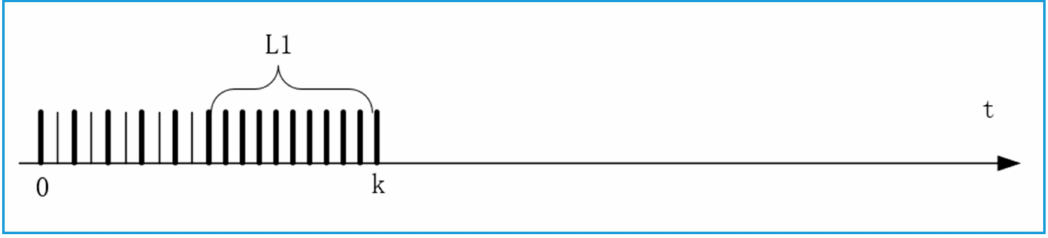
Figure 9. Schematic diagram of extracting function value by the first enlargement of step size ( N t < k ≤ nN t